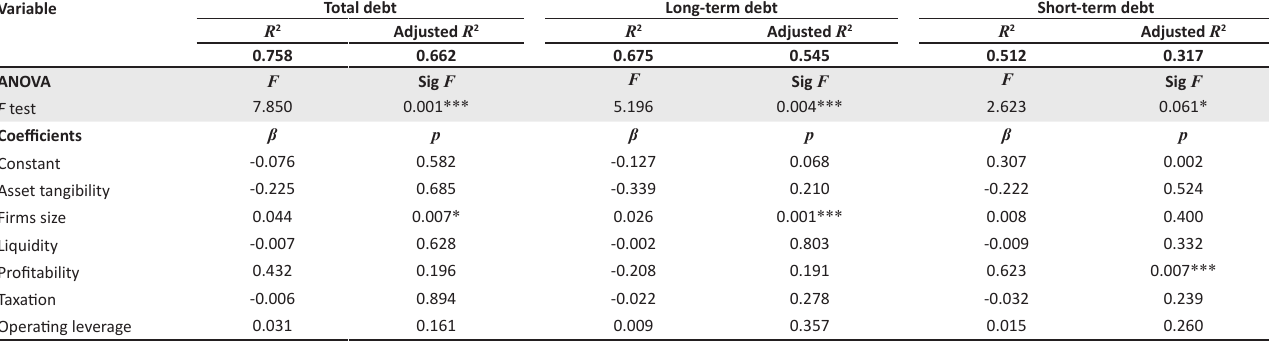
TABLE 9: Regression coefficients – Consumer services sector (1994–2015).